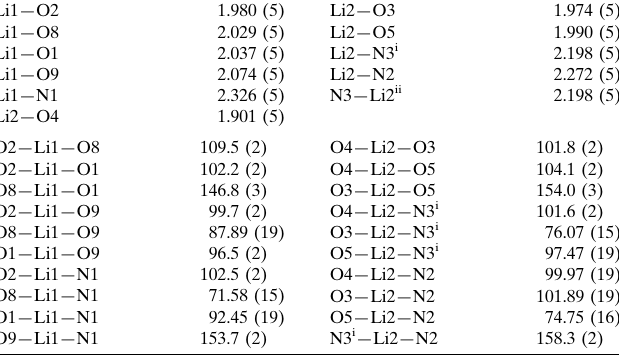
Selected geometric parameters (A˚ , (cid:2)